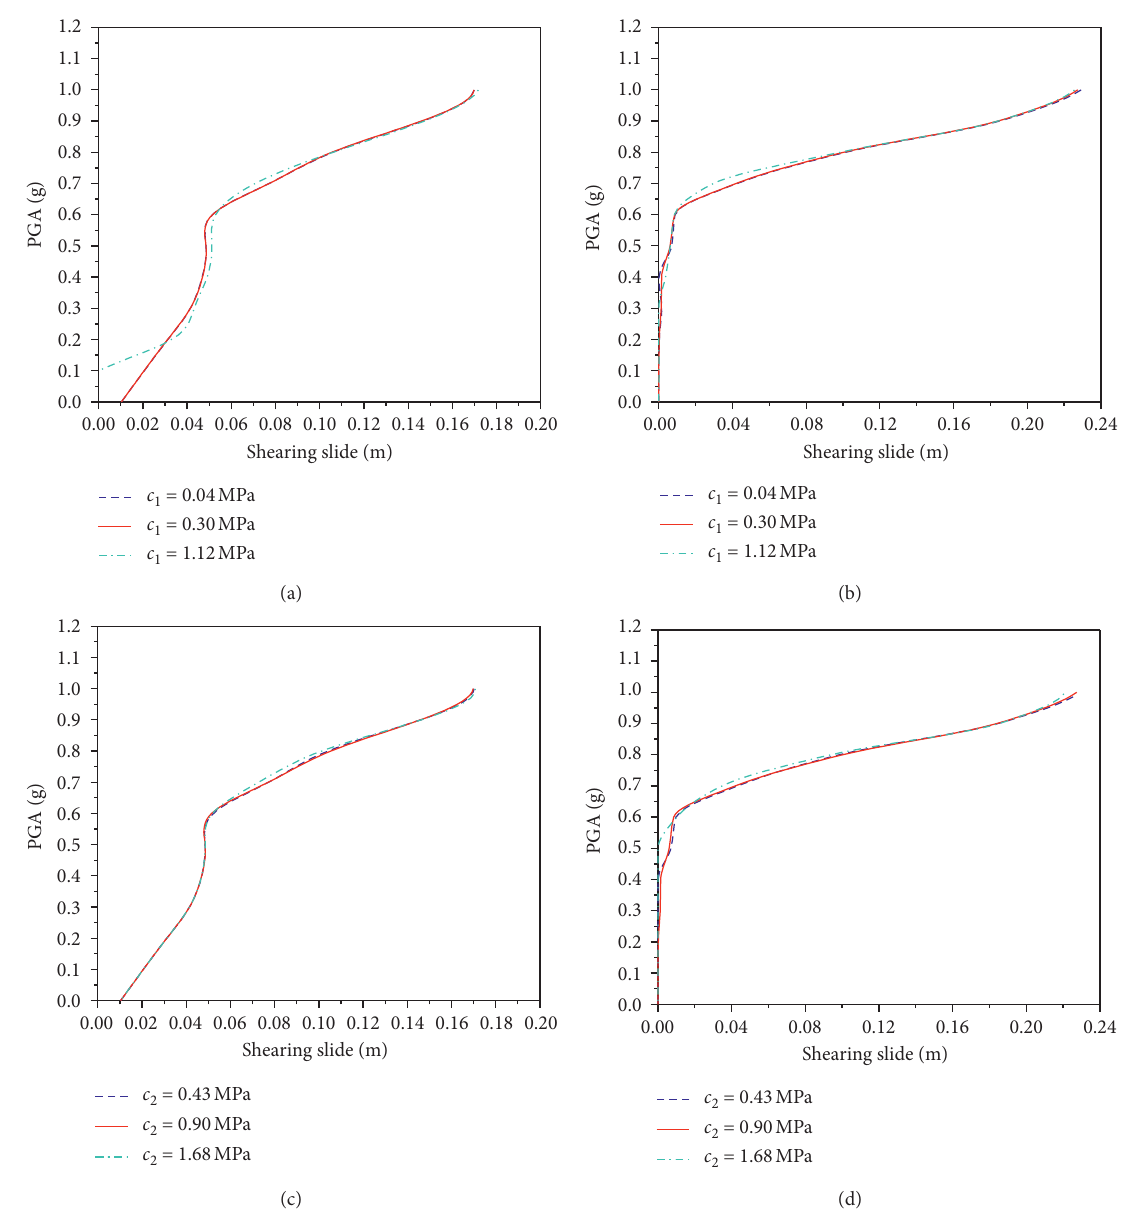
Figure 4: Sensitivity of IDA curves to cohesion: (a) c 1 affects the shearing slide of the starting point on the main sliding surface; (b) c 1 slightly affects the shearing slide of the ending point on the auxiliary sliding surface; (c) little effect of c 2 on the shearing slide of the starting point on the main sliding surface; (d) c 2 is not influential on the shearing slide of the ending point on the auxiliary sliding